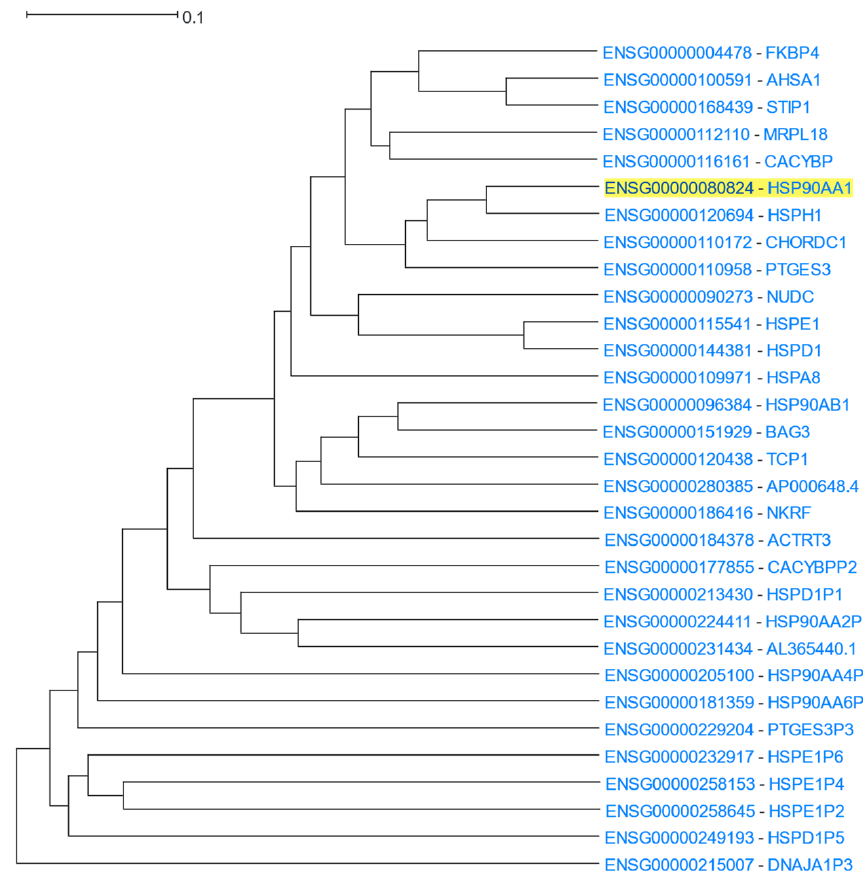
Figure 10. HGCA2.0 HSP90AA1 14 internal node coexpression clade. Table 8. Selected top gene term enrichments of the coexpressed genes to HSP90AA1 in HGCA2.0. Category p -Value Term ID